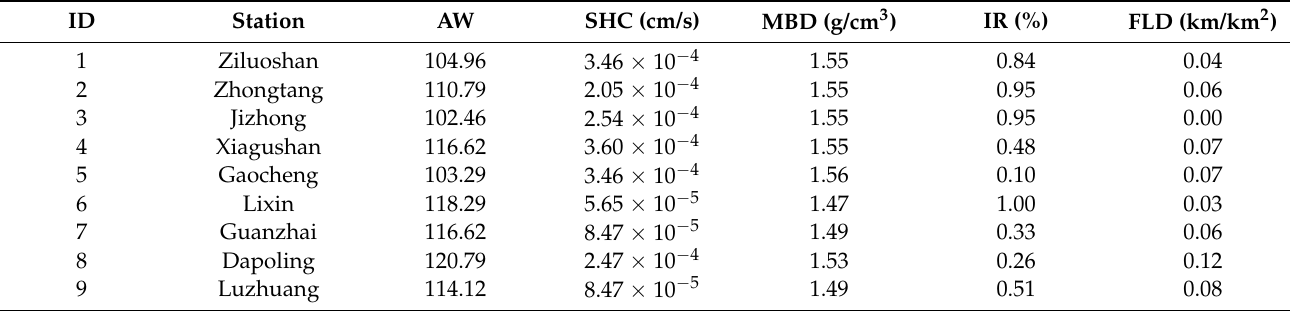
Table A3. 5 soil and geological features of 64